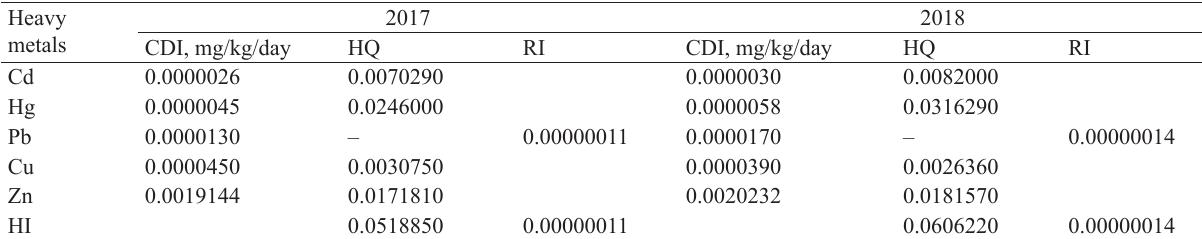
Table 5 Carcinogenic concentration of consumed fish (CDI), hazard quotient (HQ), risk index (RI), and hazard risk (HI) of elements in Merlangius merlangus L. caught near the southern coast of the Black Sea in 2017 and 2018